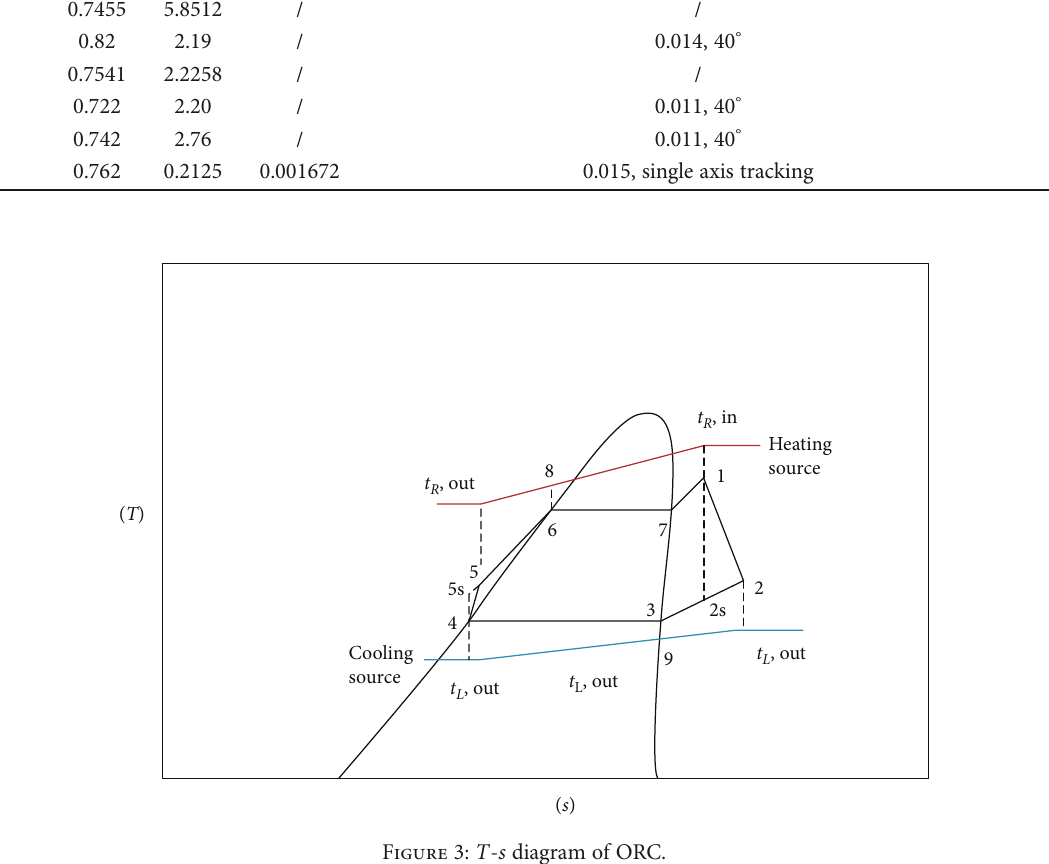
Figure 3: T - s diagram of ORC.